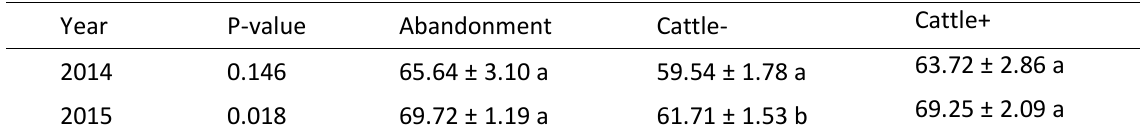
Table S1 . Nitrogen nutrition index (NNI %, Lemaire & Gastal 1997, Cruz et al., 2006) measured on forage regrowth of May in 2014 and 2015 on the non-leguminous part to assess the effect of treatments on N availability according to grazing intensity. When legumes were below 4.5% in the herbage mass, NNI was assessed using the procedure defined by Cruz et al. (2006) based on the total forage and the legume contribution. The P-values are associated with a nested mixed model: treatment used as fixed factor with plots nested in blocks as random factors. Mean ± SE is shown (n = 4). For each year, different letters correspond to significant differences at P <